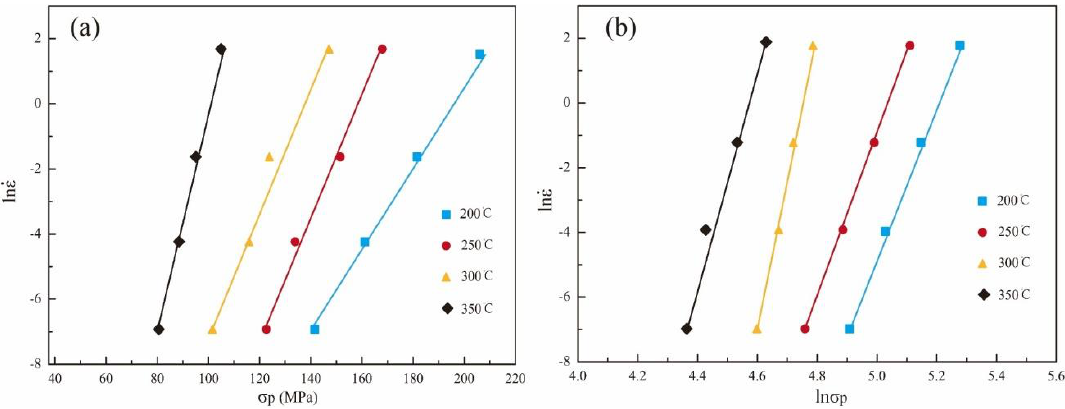
Figure 7. Relationship between flow stress and strain rate of the alloy: ( a ) ln 𝜀̇ − σ and ( b ) ln 𝜀̇ − lnσ.